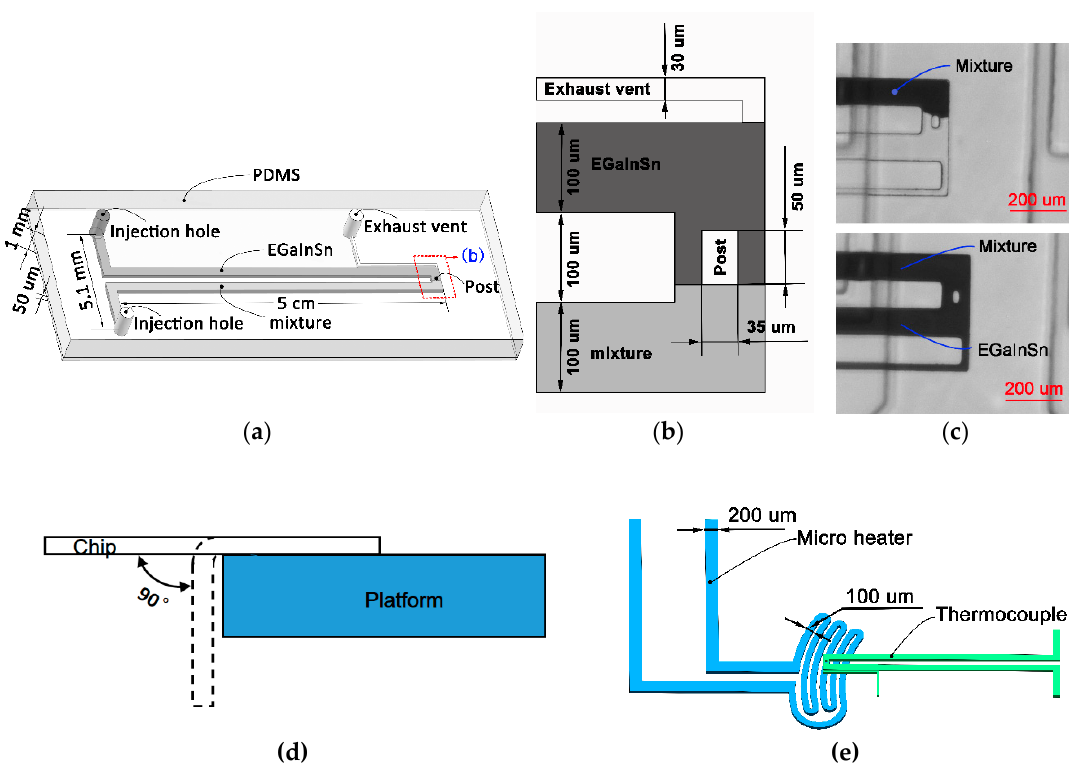
Figure 1. ( a ) Schematic of the ohm-shape micro-thermocouple; one pole of the channel was filled with EGaInSn, and the other pole of the thermocouple was filled with low-melting-point Bi-based metal–alloy mixture. ( b ) Zoom in of schematic ( a ), wherein EGaInSn and the mixture converged at the middle of the channel (sensing area). ( c ) Local map of the thermocouple chip showing that one pole of the thermocouple channel was filled with the mixture and another pole was filled with EGaInSn. ( d ) Sketch of bending test. ( e ) Sketch of temperature-measurement test. A 20 µ m-thick polydimethylsiloxane (PDMS) membrane was placed between the thermocouple and the microheater chip.